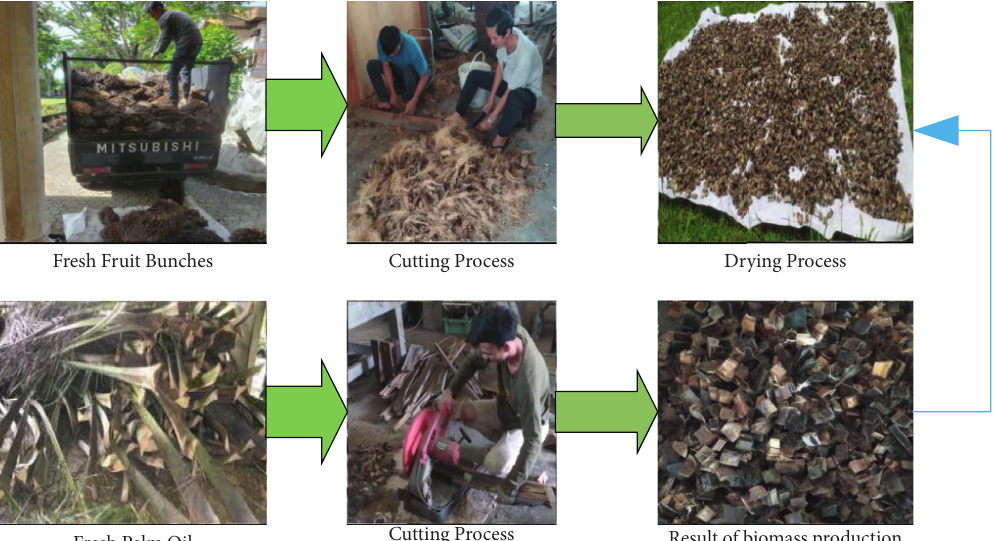
Figure 5: Production process of biomass.